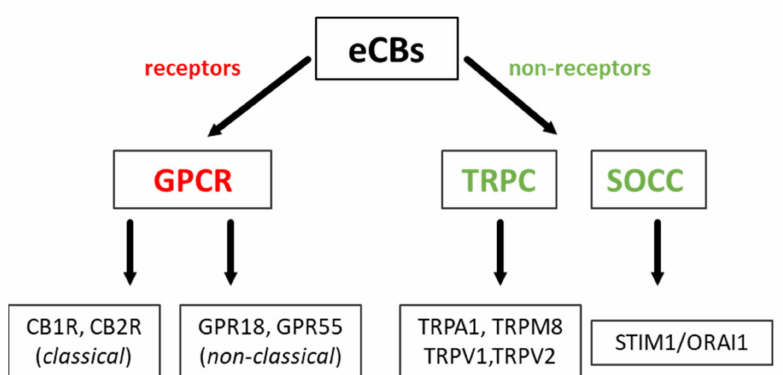
Figure 2. The schematic presentation of endocannabinoid action. GPCR—G protein-coupled recep- tors, TRPC—transient receptor potential channel, SOCC—store-operated calcium